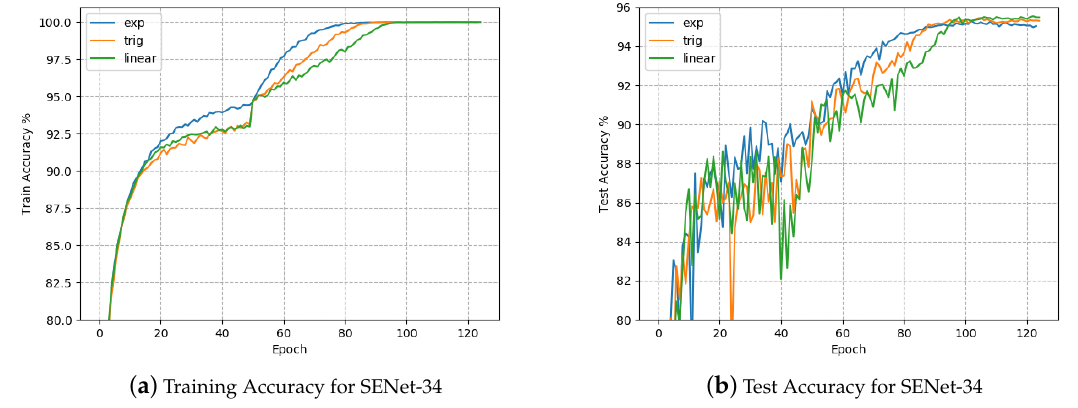
Figure 7. Training and test accuracy of different scheduling methods for SENet-34 on